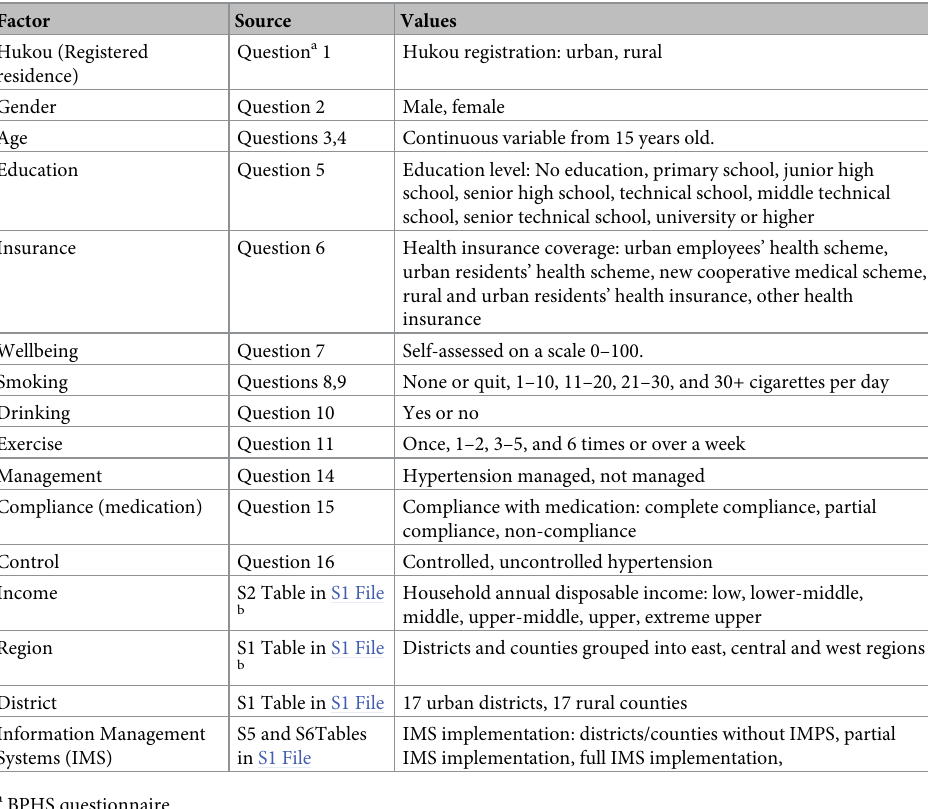
Table 2. Factors considered in analysis of hypertension